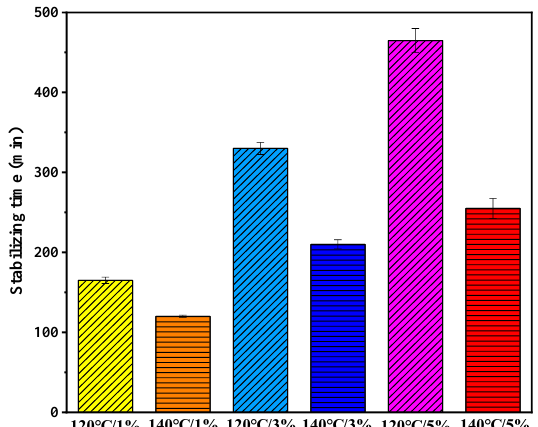
Figure 3. Stabilizing time of foamed asphalt under different conditions.